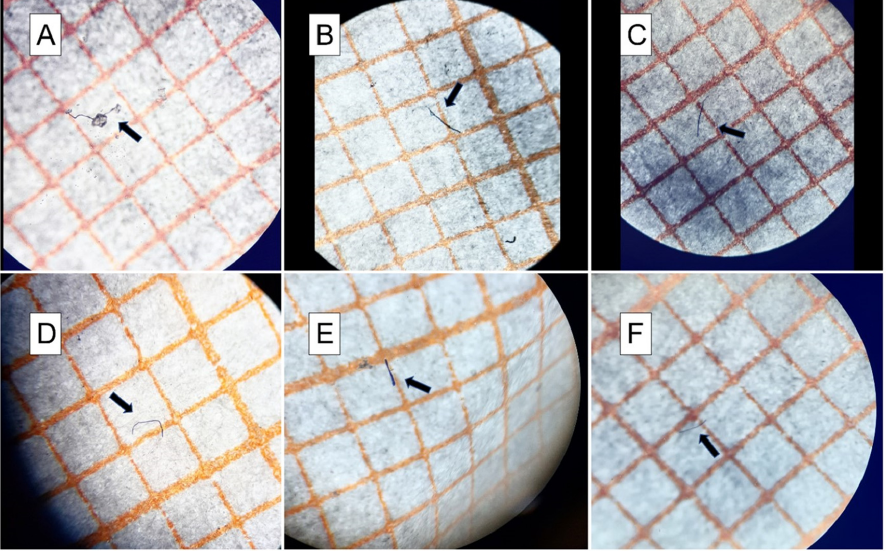
Figure 3. Example of microfibers found in wedge clams observed under stereomicroscope: ( A – C ) the largest microfibers (>1 mm), and ( D – F ) the smallest microfibers (<1 mm). Regarding size, most MPs were in the range of 0.1–1 mm (42.8%), whereas the 1.1–2 mm and 2.1–3 mm dimension ranges were present in the same percentage (28.6%) (Figure 4B). Regarding color, little variability was observed; indeed, black and blue were the most abundant color found, namely, 59.7% and 29.9%, respectively, while a small number of red MPs (9%) and transparent MPs (1.4%) was found (Figure 4A).